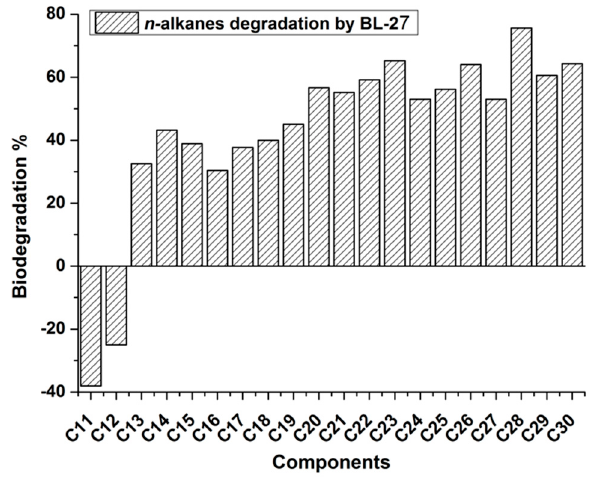
Figure 3. The variation of n -alkane components of crude oil after biodegradation by strain BL-27.